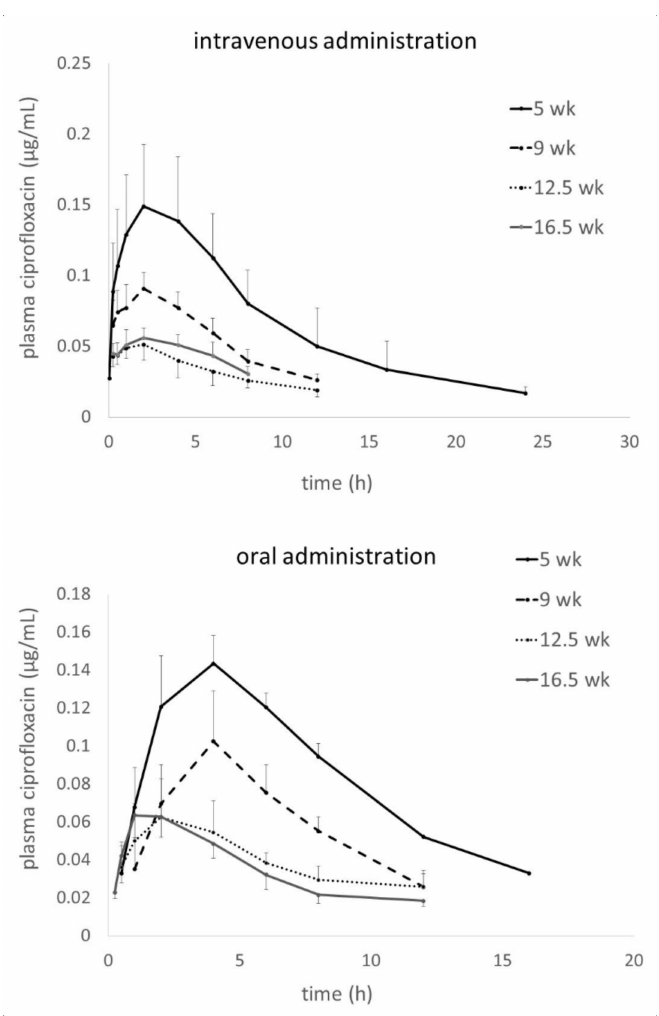
Figure 2. Plasma ciprofloxacin concentrations after single intravenous (upper panel) and oral dose (lower panel) of enrofloxacin calculated according to the protocol: Dose = 30 × BW 0.59